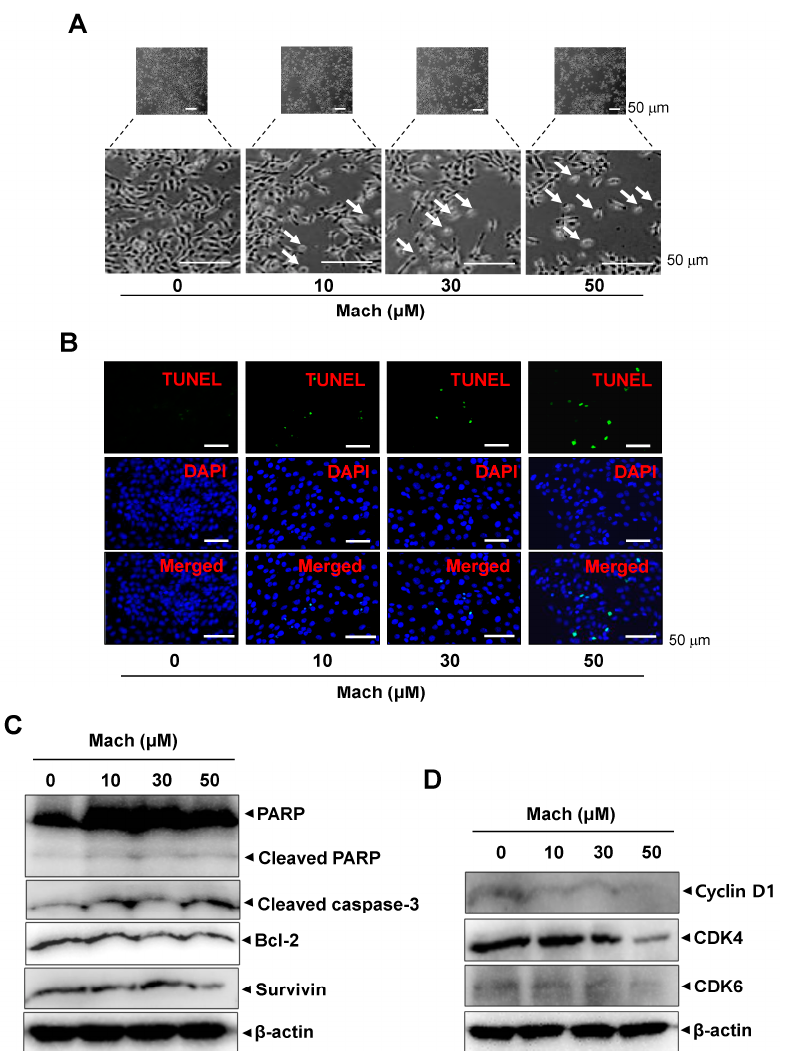
Figure 5. Effects of Mach on apoptosis in human YD-10B OSCC cells. ( A ) Apoptotic morphological changes were imaged using a light microscope. Scale bar: 100 μ m. ( B ) Apoptosis was assessed using TUNEL (green) and DAPI (blue) staining. Images were obtained using a microscope. Scale bar: 50 μ m. ( C ) Western blotting of PARP, cleaved PARP, cleaved caspase 3, Bcl-2, and Survivin levels. ( D ) Western blotting of cyclinD1, CDK4, and CDK6 levels. β -actin was included as a loading control. Data are representative of the results from three separate experiments. Statistical significance was analyzed using Student’s unpaired t -test.